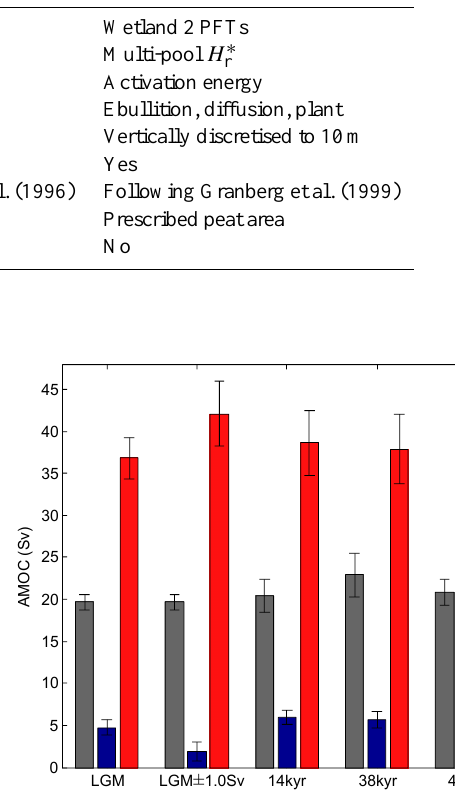
Fig. 1. 30yr mean ± 1 standard deviation Atlantic meridional over- turning circulation (AMOC) values for the three phases of each cli- mate simulation: grey for EQ (equilibrium), blue for HS (Heinrich stadial-like) and red for GI (Greenland